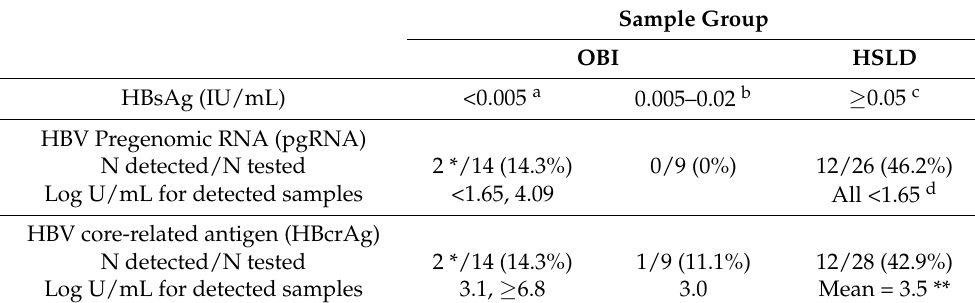
Table 7. Detection of representative OBI and HSLD samples by novel biomarker